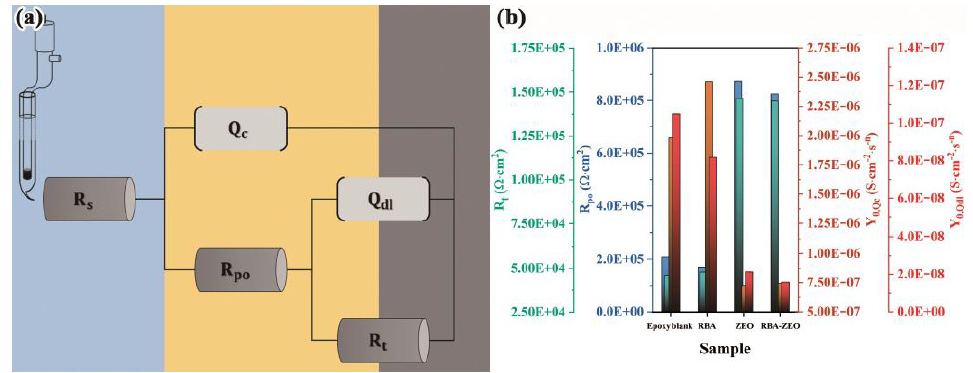
Figure 5. The ( a ) equivalent circuit for the fitting of electrochemical impedance spectroscopy and ( b ) the fitting results. Table 2. The fitting results of electrochemical impedance spectroscopy. Coatings